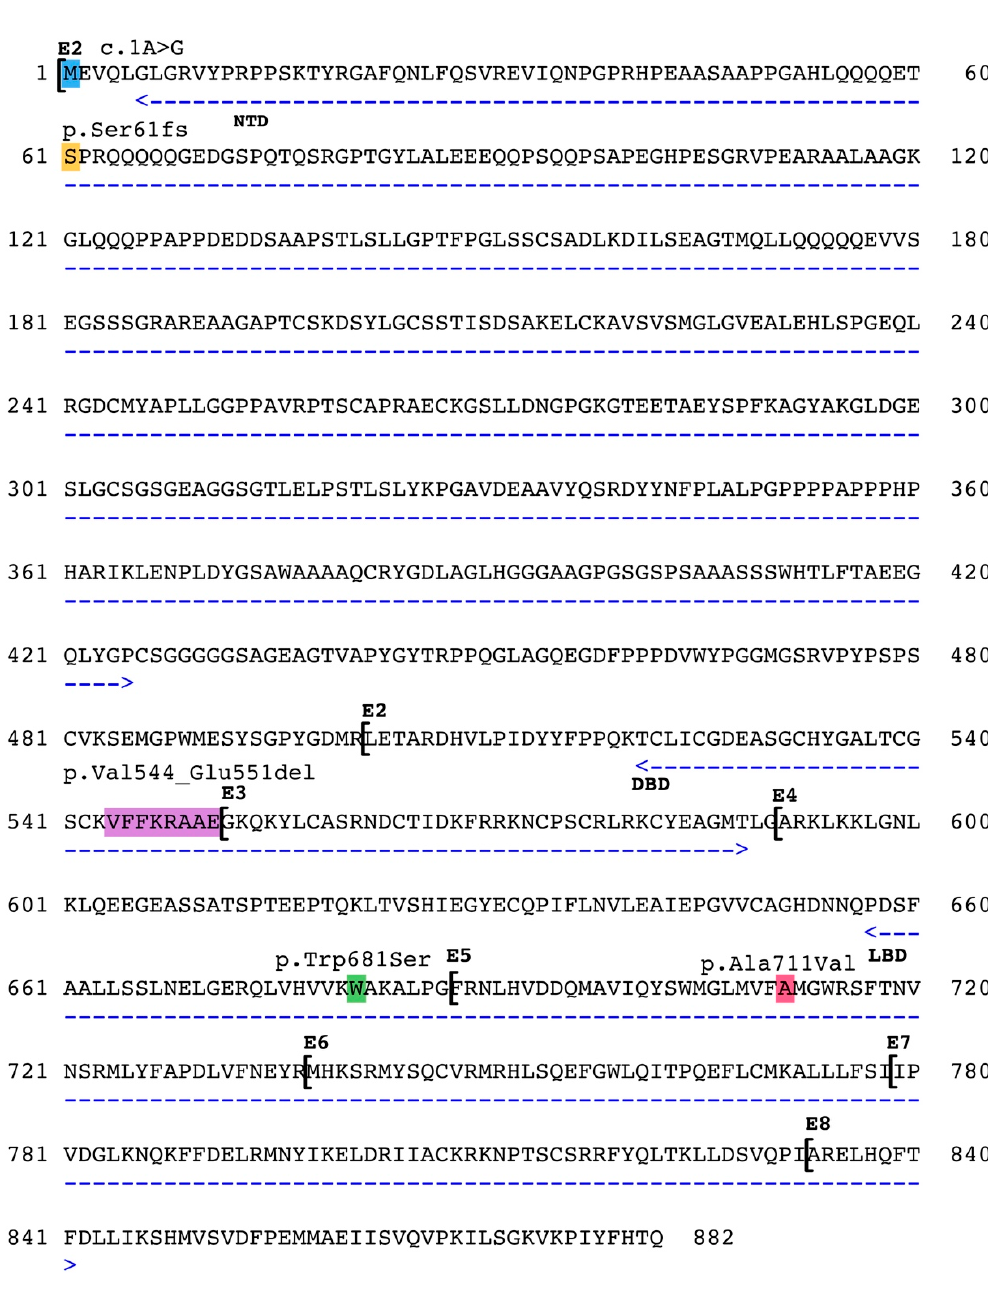
Figure 2. Pathogenic variations in the horse AR. Functional domains are marked with arrows, NTD = N-terminal Domain, DBD = DNA Binding Domain, LBD = Ligand Binding Domain. Exons marked with E1-E8. c.1A > G by Revay et al., 2012 [9], p.Val544_Glu551del by Welsford et al., 2017 [14], p.Trp681Ser by Bolzon et al., 2016 [8]. The p.Ser61fs and the p.Ala711Val variants